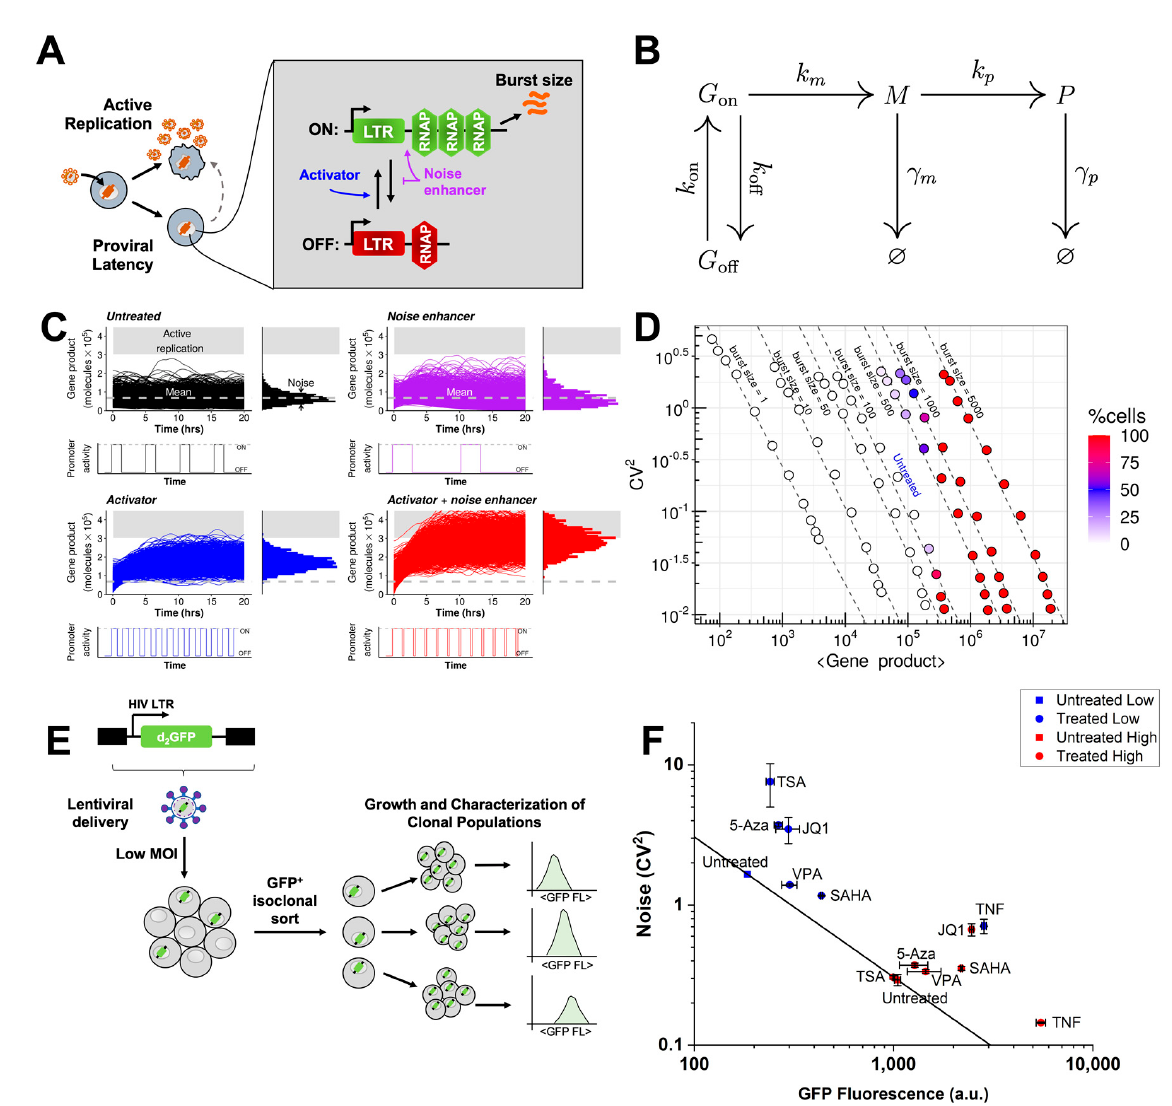
Figure 1. Model of episodic transcription predicts enhanced expression levels between compounds that increase tran- scriptional burst size and transcriptional burst frequency. ( A ) Schematic of human immunodeficiency virus (HIV) active replication, proviral latency, and latent reactivation (dashed arrow). (Inset) The HIV promoter transitions between an “off” state and a transcriptionally permissive “on” state at rates k on (upward arrow) and k off (downward arrow), respectively, and transcribes with rate k m (horizontal arrow) in the “on state”. Activators of the long terminal repeat (LTR, blue) modulate k on to increase expression rate, whereas adjusting k m /k off (purple) primarily modulates expression noise. ( B ) The two-state model of transcriptional bursting for gene expression. The promoter is either in the on state (G on ) or the off state (G off ). Transcription of mRNA (M) only happens from the on state. Protein (P) is translated from the mRNA. Both mRNA and protein undergo degradation. The kinetic parameters for each transition reaction are also mentioned. The different parameters in the model are—k on : promoter on rate; k off : promoter off rate; k m : rate of transcription from the on state; k p : rate of translation; γ m : mRNA degradation rate and γ p : protein degradation rate. ( C ) Simulations exhibiting the synergistic effect of combining a noise enhancer with an activator. These simulations were performed for the two-state model of transcriptional bursting for the LTR promoter. Each sub-panel shows single-cell time series trajectories as line traces